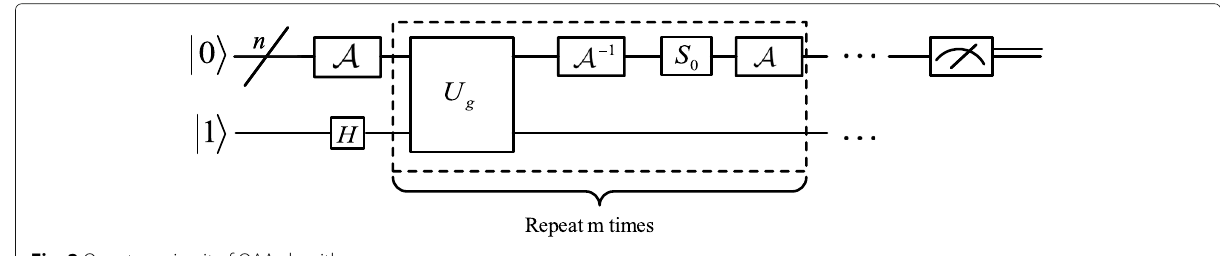
Fig. 2 Quantum circuit of QAA